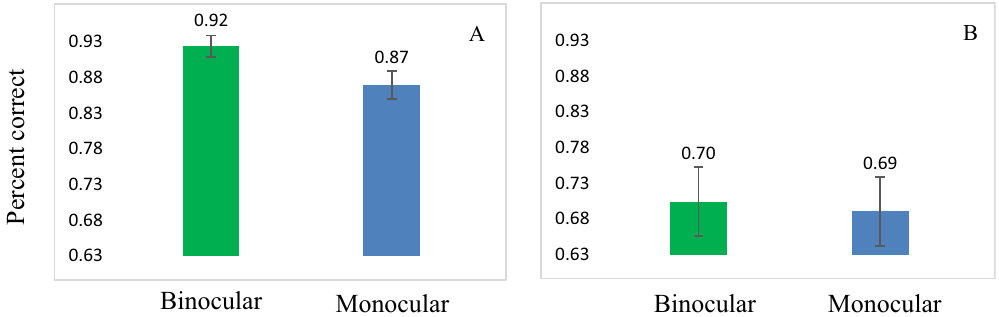
Figure 5. Single letter versus crowding (for a duration time of 120 ms): Percent correct: ( A ) for a single black target letter. ( B ) for black